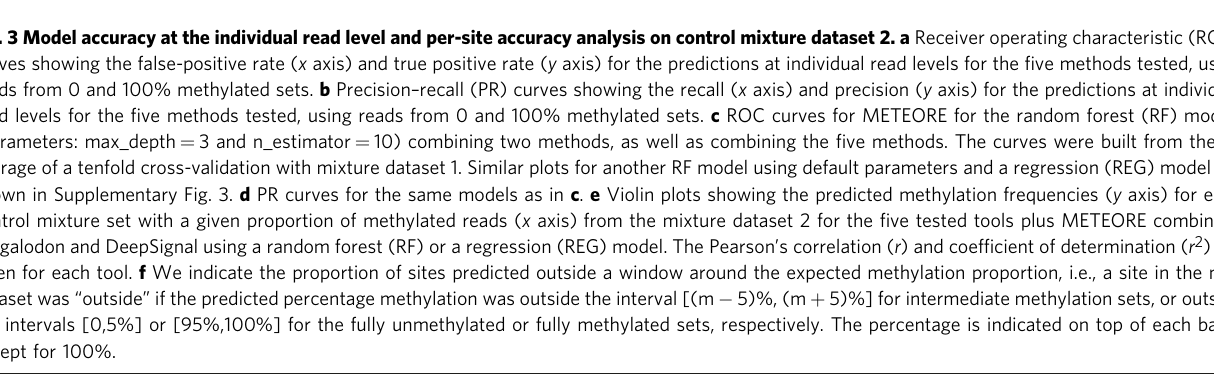
Fig. 3 Model accuracy at the individual read level and per-site accuracy analysis on control mixture dataset 2. a Receiver operating characteristic (ROC) curves showing the false-positive rate ( x axis) and true positive rate ( y axis) for the predictions at individual read levels for the fi ve methods tested, using reads from 0 and 100% methylated sets. b Precision – recall (PR) curves showing the recall ( x axis) and precision ( y axis) for the predictions at individual read levels for the fi ve methods tested, using reads from 0 and 100% methylated sets. c ROC curves for METEORE for the random forest (RF) model (parameters: max_depth = 3 and n_estimator = 10) combining two methods, as well as combining the fi ve methods. The curves were built from the